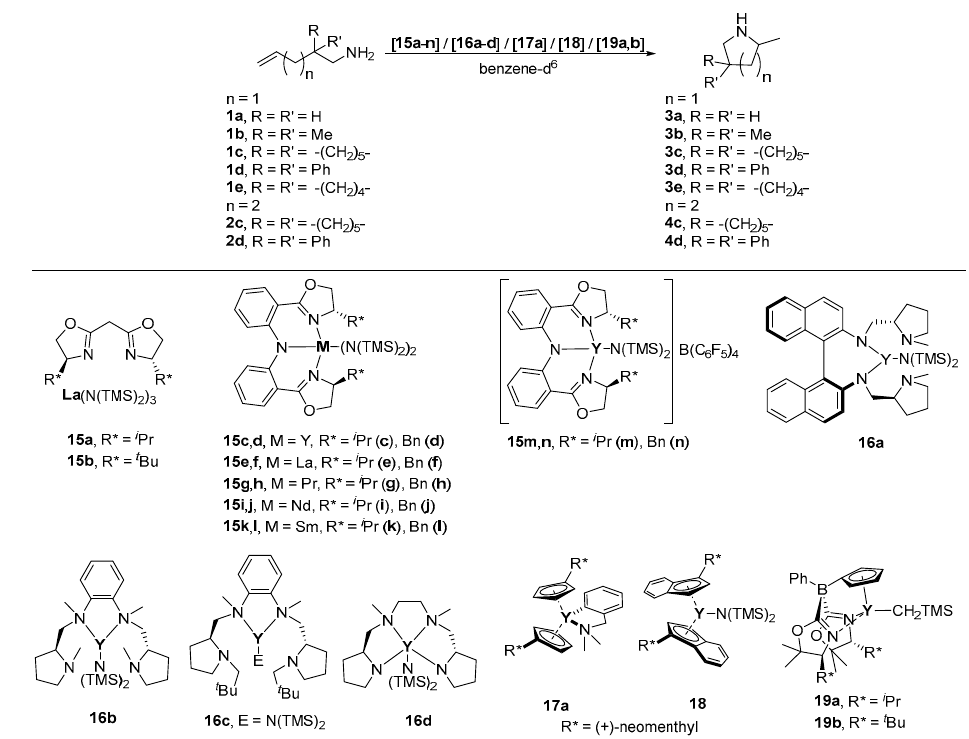
Table 4. Catalytic asymmetric hydroamination reactions of 1a – e and 2c , d using chiral rare